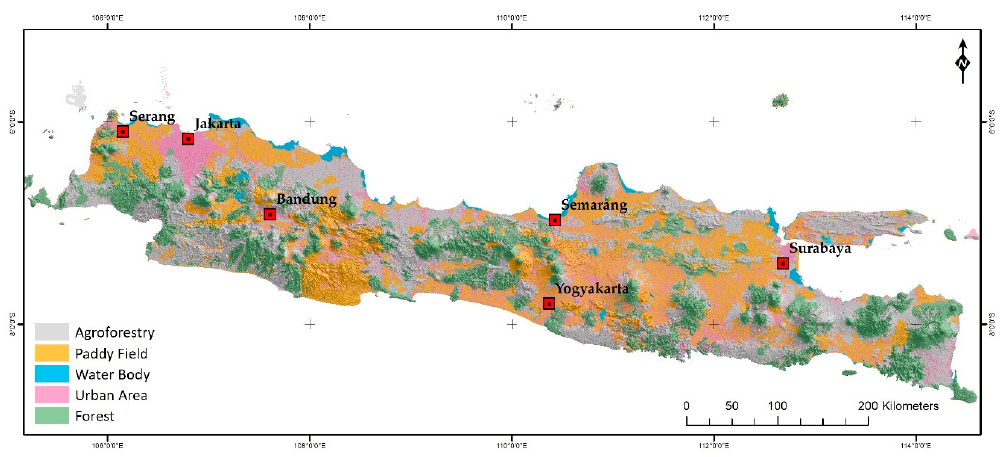
Figure 1. Rain-fed agriculture in the form of agroforestry and cassava field is extensive land use type in.